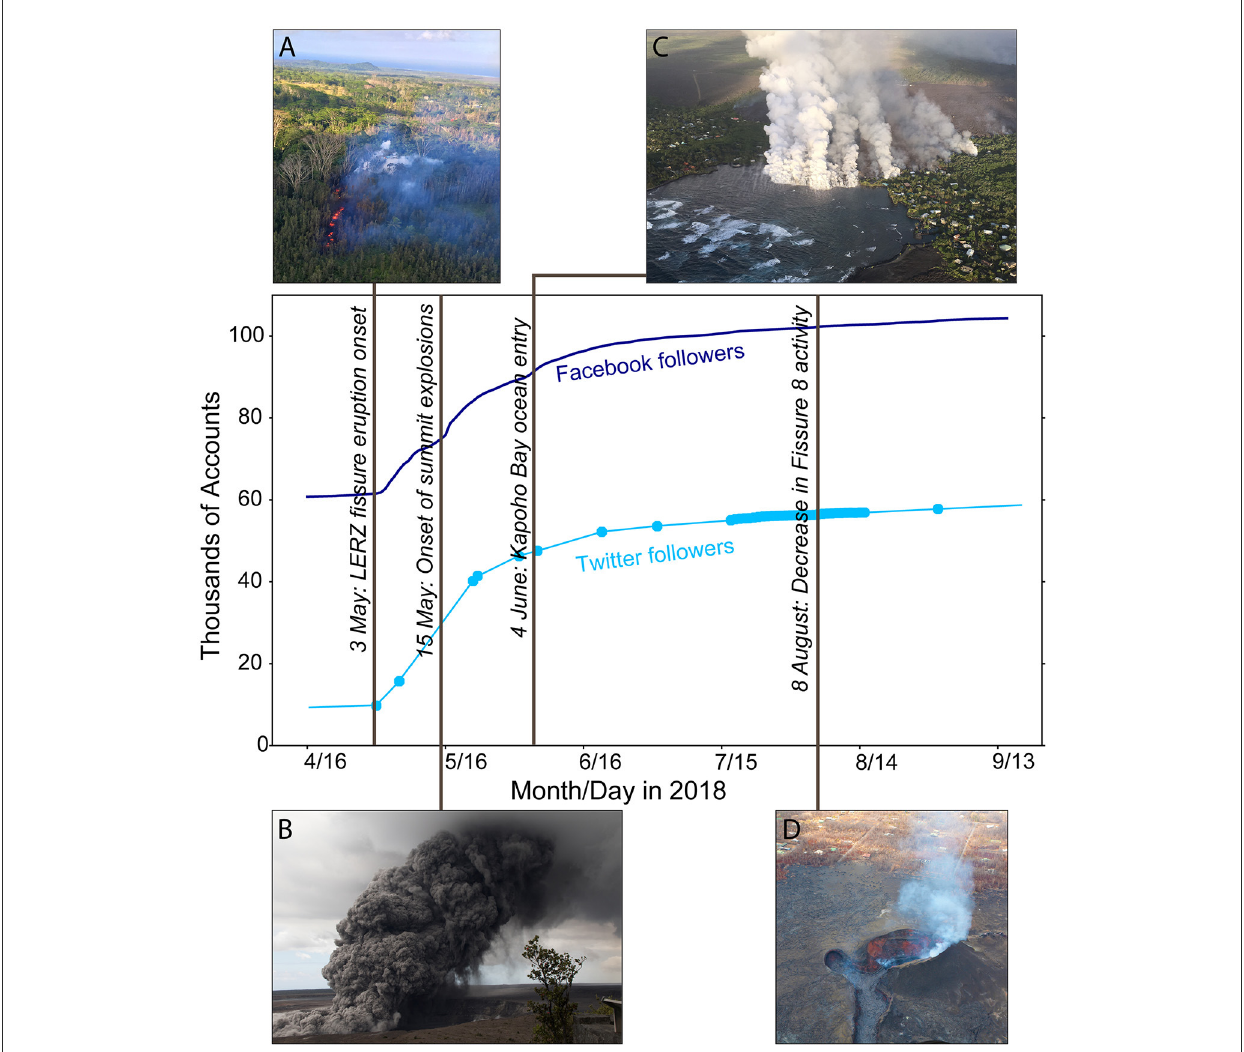
FIGURE3 Audience growth for both Facebook and Twitter occurred rapidly following the onset of the K¯ılauea lower East Rift Zone eruption on May 3, 2018. Similarly, followership gains occurred after significant events in the eruption timeline, notably the onset of explosions at K¯ılauea’s summit and as lava encroached into Kapoho and filled the bay. Data for Facebook are daily follower counts. Follower counts from Twitter were recorded for the first day of each month until the middle of July when daily tallies were made. USGS Photographs: (A) On May 3, 2018, at ∼ 5:00 p.m. HST, fissures opened in the forested neighborhood of Leilani Estates and began erupting low lava fountains and volcanic gas (blue-tinged plume in image). (B) May 15, 2018, 11:05a.m. HST, a dense ash plume rose from K¯ılauea volcano summit. (C) An aerial photograph of June 4, 2018, 6:13a.m. HST, shows the lava flow originating from Fissure 8 (not visible in photograph, Figure 1) entering Kapoho Bay. (D) The fissure 8 vent had minimal visible lava activity through September (this photo from August 8,